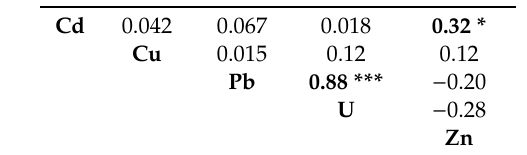
Table 3. Correlation matrix of Heavy Metals and